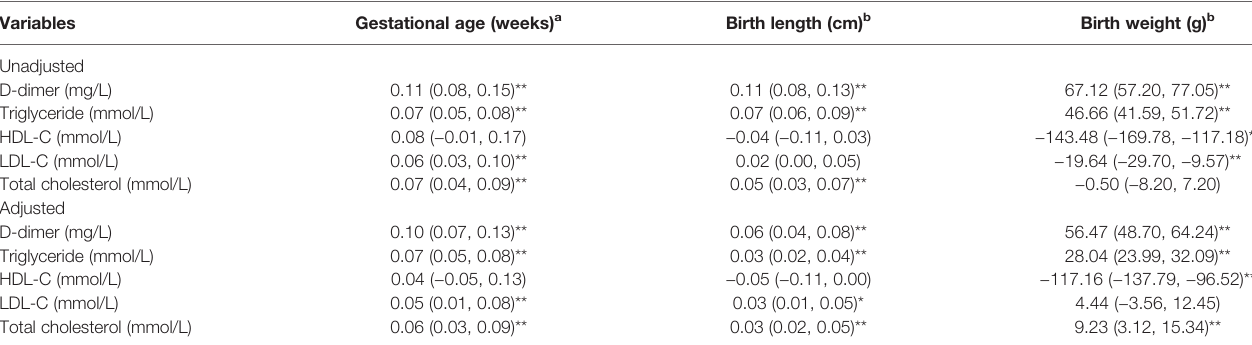
TABLE 3 | Regression coef fi cients [ b (95% CI)] for neonatal development associated with maternal D-dimer and blood lipid